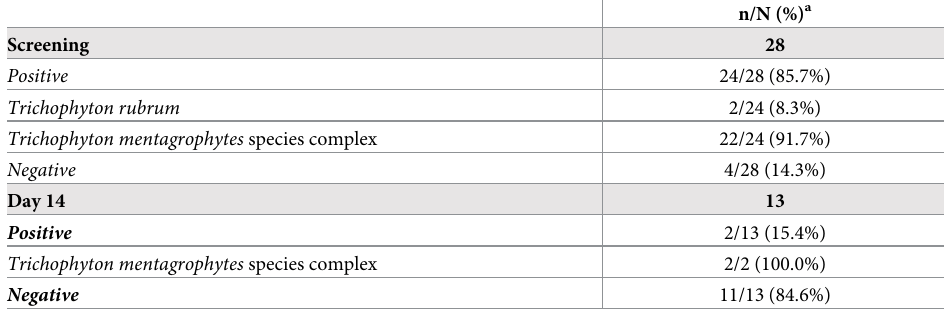
in plasma prior to dosing on Day 7 in 23 of the 26 available samples with an LLOQ of 20 ng/ mL for both the analytes. Of the 3 participants who had plasma concentrations BQL prior to dosing on Day 7, one participant also had no quantifiable plasma concentrations of itracona- zole and hydroxy-itraconazole at 2 hours and 4.5 hours postdose. At Day 7, the mean plasma concentrations for itraconazole and hydroxy-itraconazole in non-responders (participants with a clinical response score of 3 to 5) was comparable to that of responders (participants with a clinical response score of 1 or 2 [healed or markedly improved]; Table 3). Clinical response at Day 7 was not associated with the highest or lowest plasma concentra- tions of itraconazole or hydroxy-itraconazole. Of the 3 participants with predose plasma con- centrations BQL on Day 7, two participants were classified as responders (clinical response score = 2 [markedly improved]) and 1 participant was classified as a nonresponder (clinical response score = 5 [worse]). All 3 participants had positive fungal cultures for T . mentagro- phytes species complex at screening. On Day 14, 1 of the 3 participants had a positive fungal